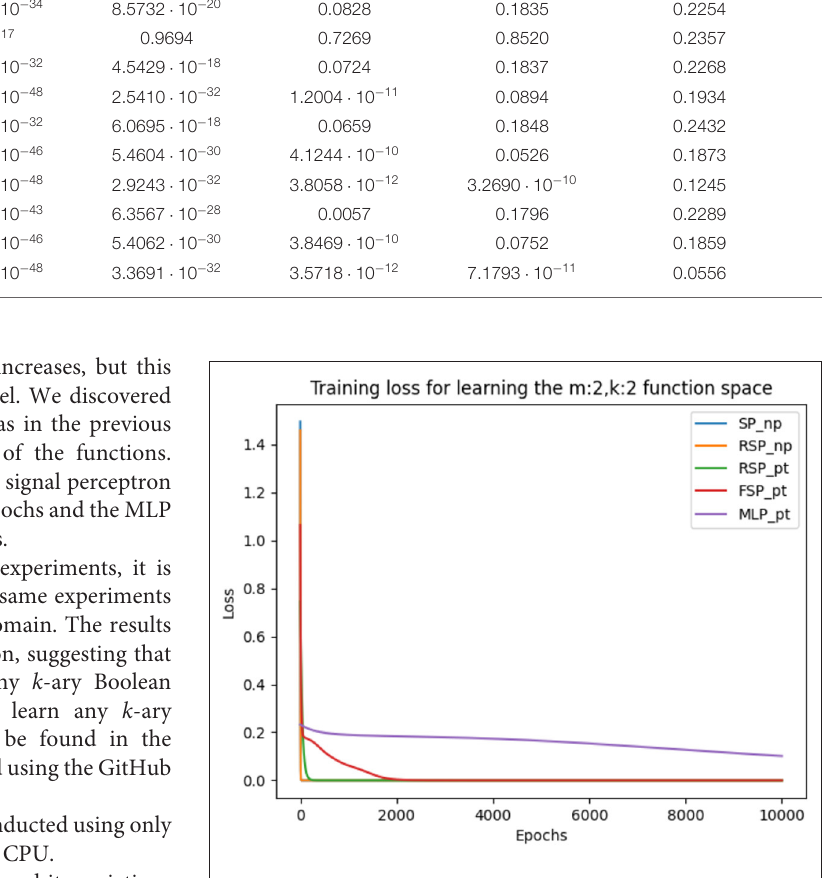
FIGURE 5 | Figure that plots the loss function of different architectures when learning the whole binary Boolean space simultaneously with batch gradient descent for 10,000 episodes and learning rate of